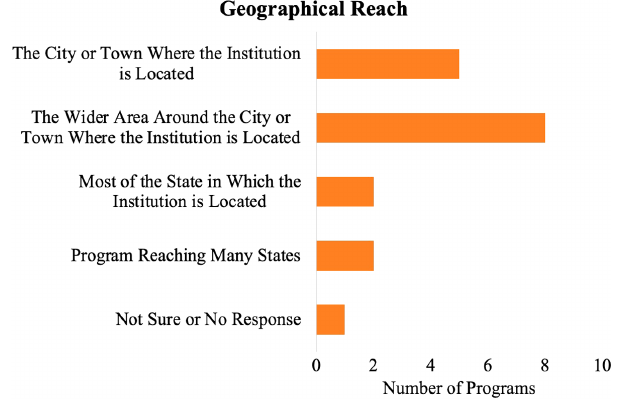
FIG. 9. The geographical reach of the programs in our sample.